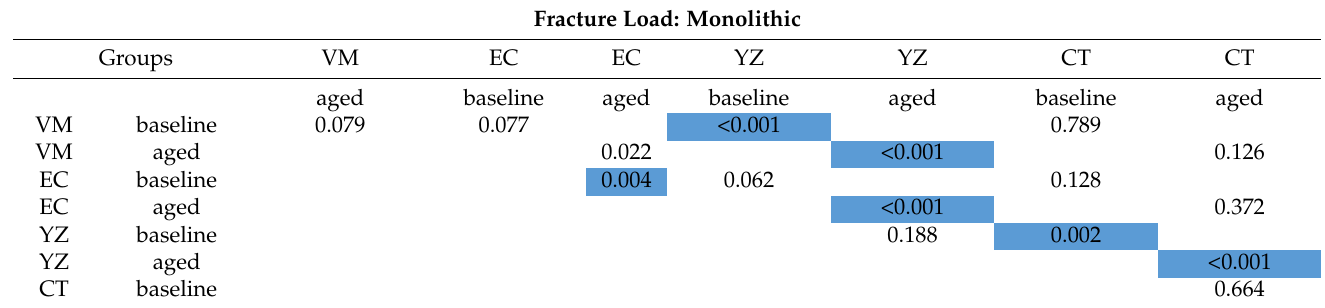
Table A1. Cont. Fracture Load: Monolithic